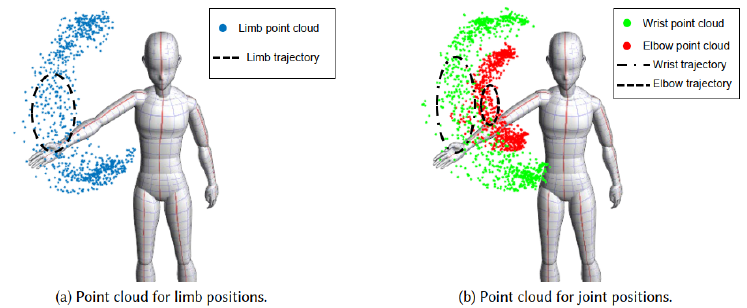
Figure 14. Examples of point clouds reconstructing limb and joint positions.